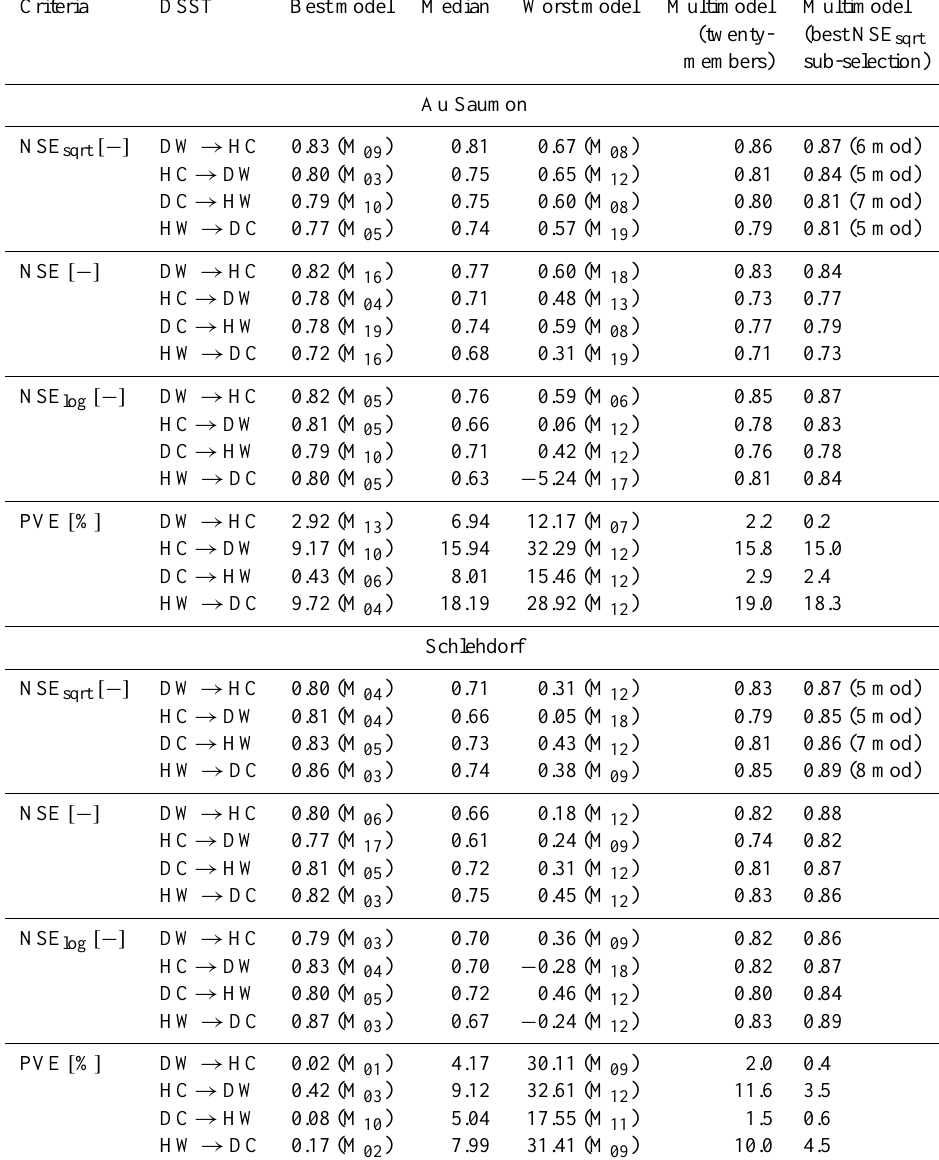
Table 3. Validation performance (DSST) for individual models and multimodel for the Au Saumon and Schlehdorf catchments.